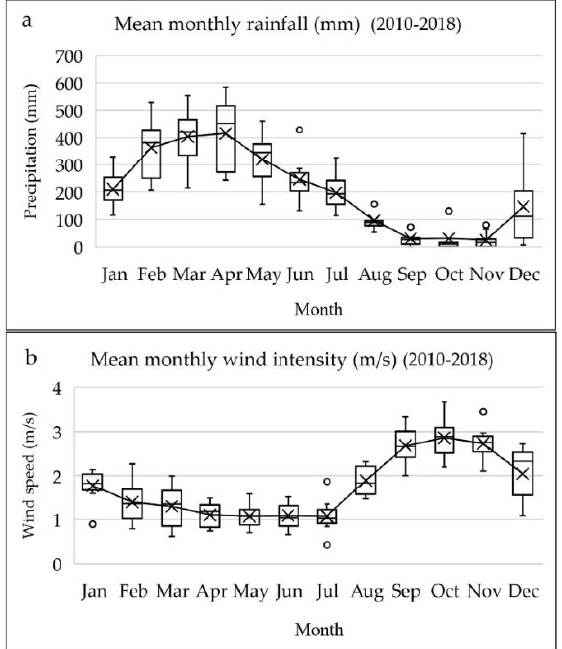
Figure 2. ( a ) Mean monthly rainfall (mm) and ( b ) mean monthly wind velocity intensity (m/s) (2010-2018). Source: BDMEP-INMET.